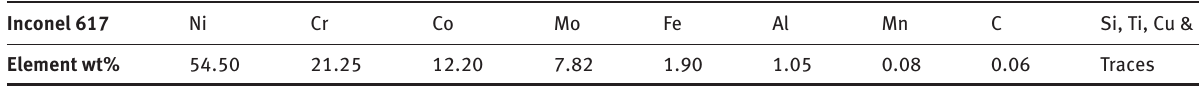
Table 1: The chemical composition of Inconel 617